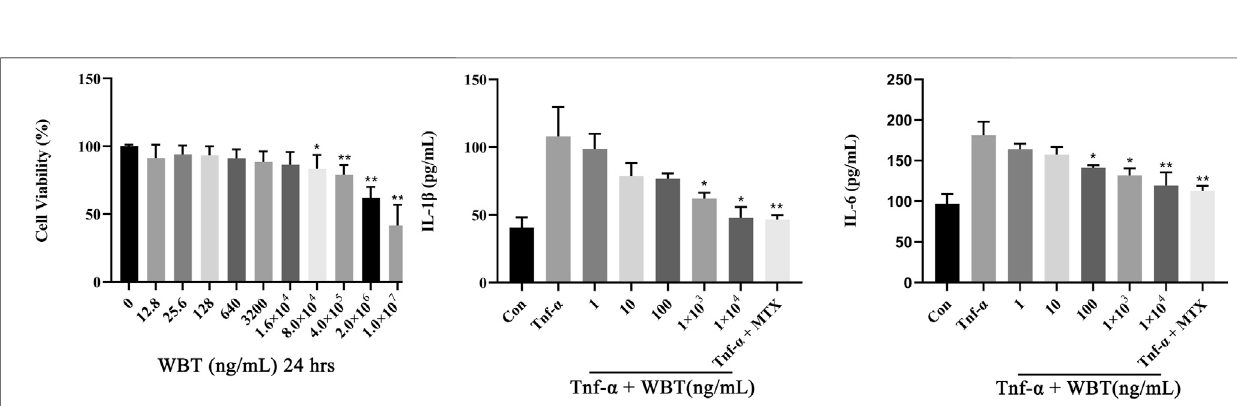
FIGURE 4 | WBT prevents in fl ammatory response induced by TNF- α in RAW264.7 cells in a dose-dependent manner. Cell viability was determined by MTT assay (A) . The levels of IL-1 β (B) and IL-6 (C) in cell culture supernatant were detected by ELISA kits (Mean ± SD, p < 0.05*, p <